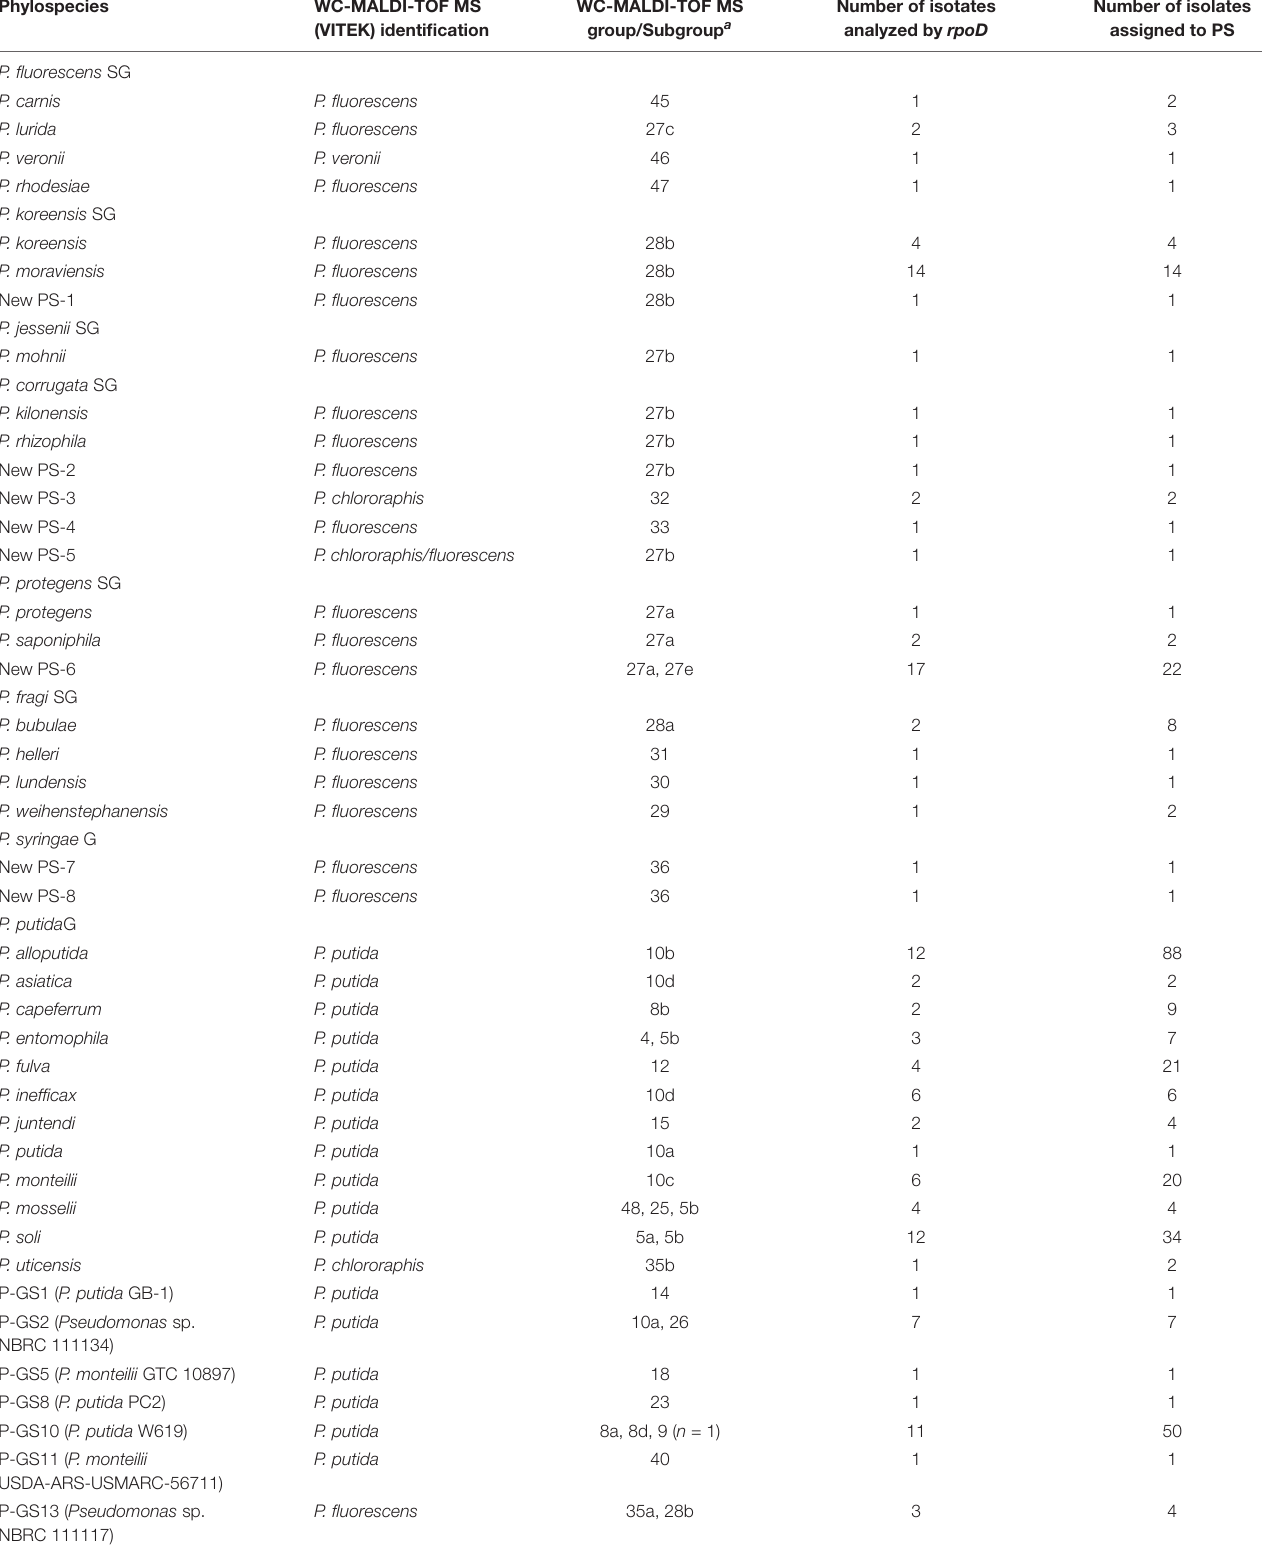
TABLE 1 | Groupings of strains based on the MALDI-TOF MS protein profiles and on the rpoD sequence analyses and their assignation to phylospecies. Phylospecies WC-MALDI-TOF MS